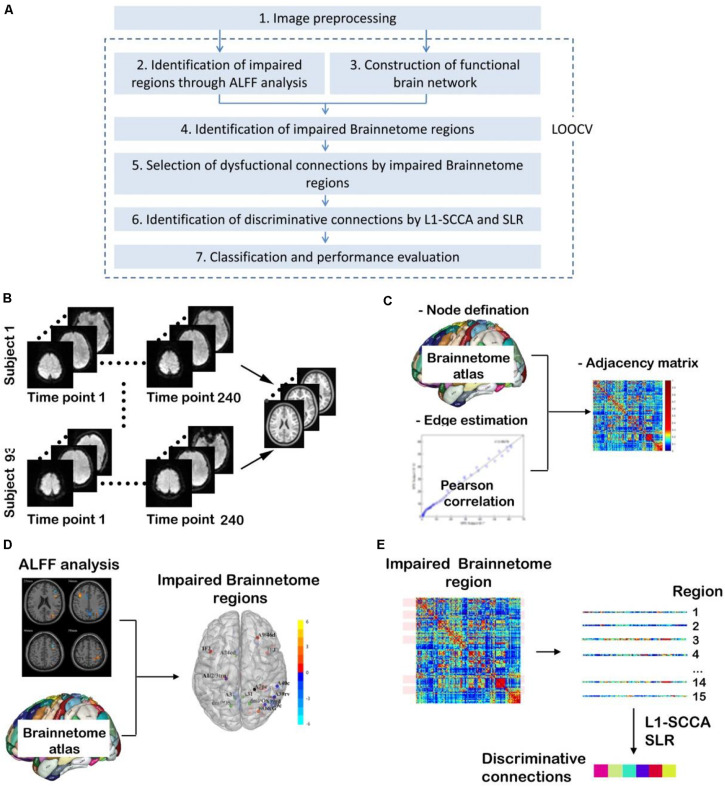
Overview of study procedure. (A) Main steps in this study [It is noted that steps from (2) to (7) are carried out many times since they are included in a procedure of leaving-one-out cross validation (LOOCV) to avoid the leakage of category information]; (B) Image preprocessing; (C) Construction of functional brain network; (D) Identification of impaired Brainnetome subregions by ALFF analysis; (E) Identification of discriminative connections by L1-SCCA and spare logistic regression (SLR).